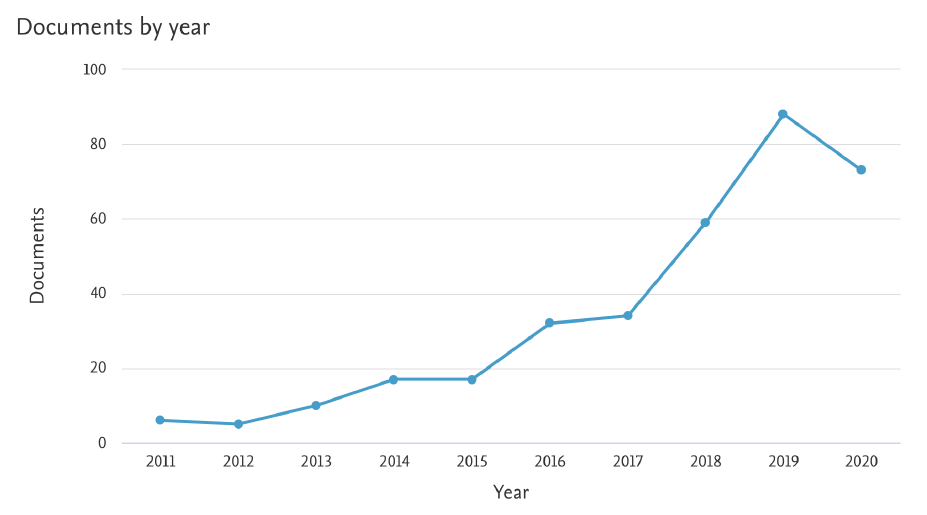
Figure 2. The number of microexpression recognition publications from 2011 to 2020 (Data Source: